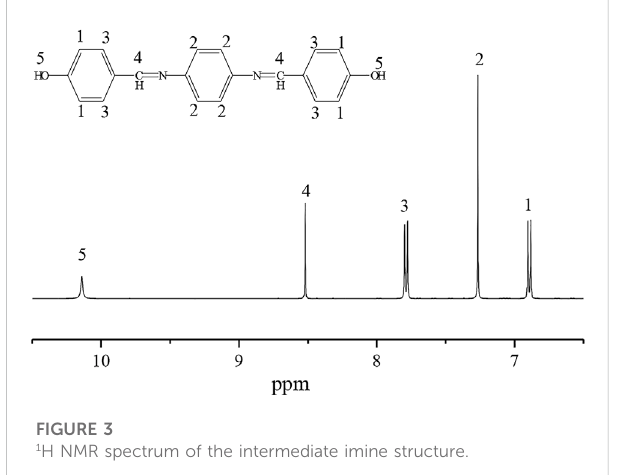
FIGURE 3 1 H NMR spectrum of the intermediate imine structure.